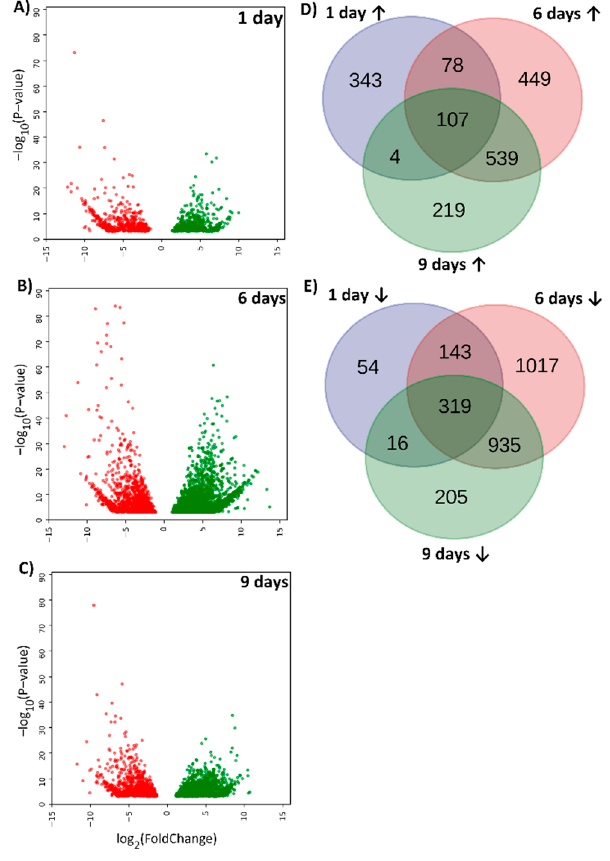
Figure 6. Microcystin-LR (MC-LR) induced differentially expressed (DE) putative novel lncRNAs in whitefish liver. Volcano plots after 1 day ( A ), 6 days ( B ) and 9 days ( C ) of exposure; data points represent downregulated (red) or upregulated (green) putative novel lncRNAs. Venn diagrams of upregulated ( D ) and downregulated ( E ) putative novel lncRNAs after MC-LR exposure. Note that days 6 and 9 are more similar to each other than to day 1 in terms of which lncRNAs were DE on those days. Thresholds of a log2 fold-change > |2| and an adjusted p -value < 0.001 were used to filter out contigs with the smaller and less statistically significant differences between groups.